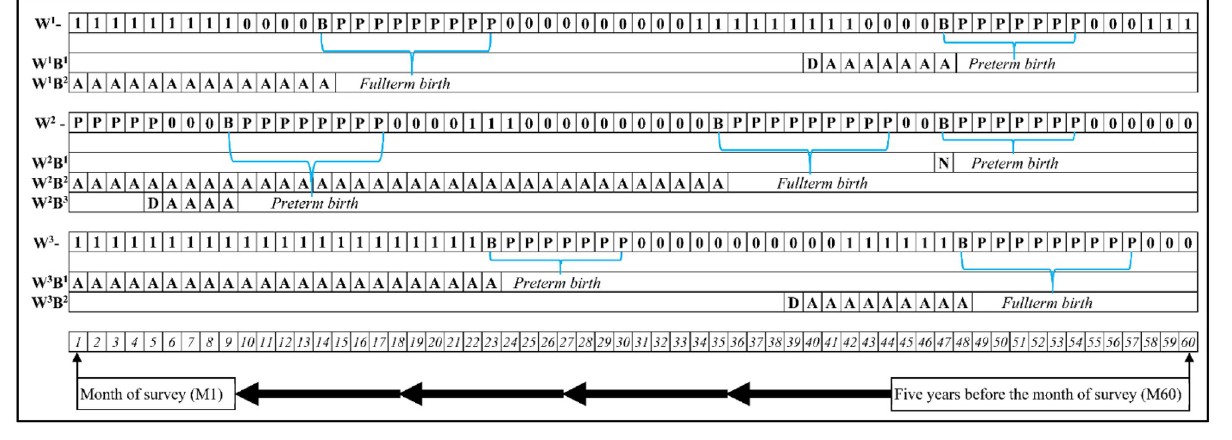
Fig 1. Reproductive calendar showing estimation of preterm birth and mortality outcomes. Note. W-Women, P- Pregnant, B- Birth, 0- not using any contraception, 1- using contraception, A- Alive, N- early-/ late- neonatal death, D- postneonatal death, One box represents one month.